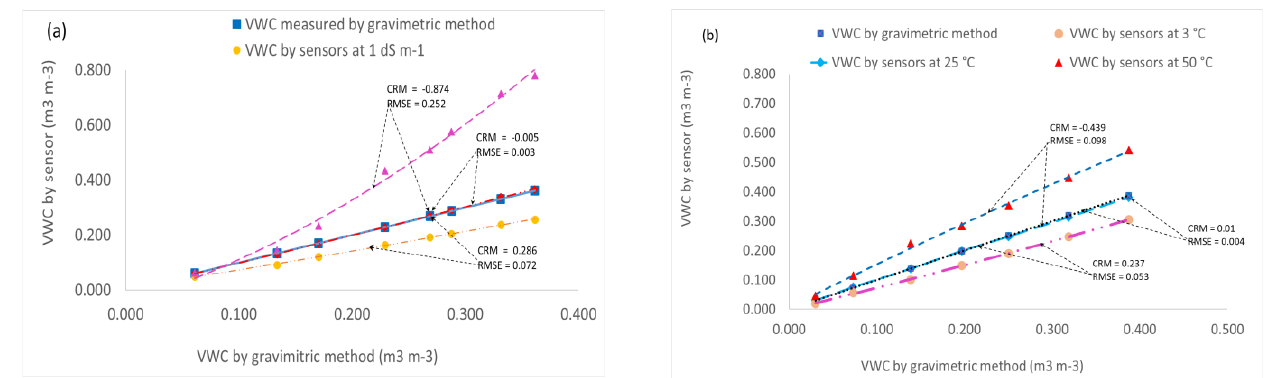
Figure 3. Correlation between actual VWC by gravimetric method and the sensor at three levels of ( a ) salinity concentration and ( b ) temperature.